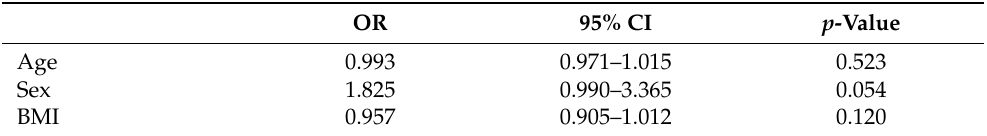
Table 5. Multiple logistic regression analysis and odds ratios (OR) with 95 % confidence intervals for a diagnosis of adherence to the Mediterranean diet.